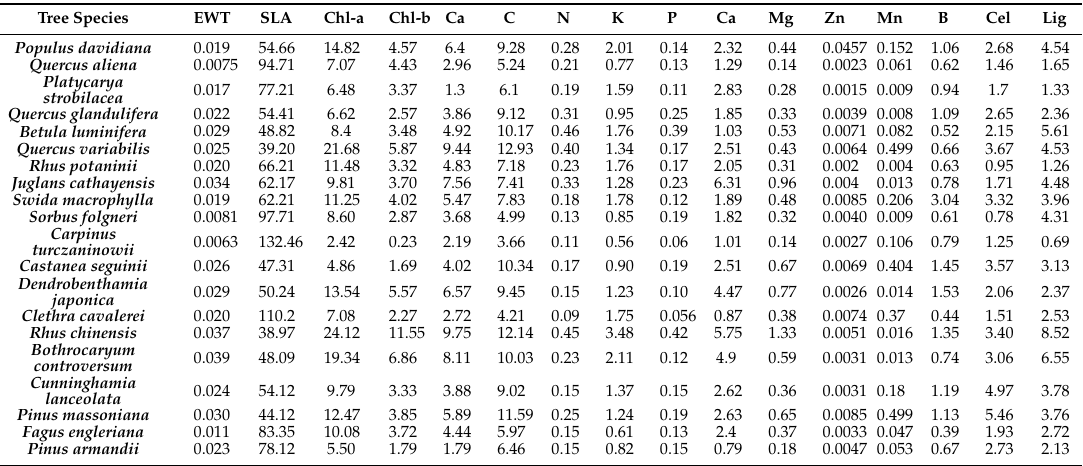
Table 1. Description of sixteen biochemical values of twenty species.